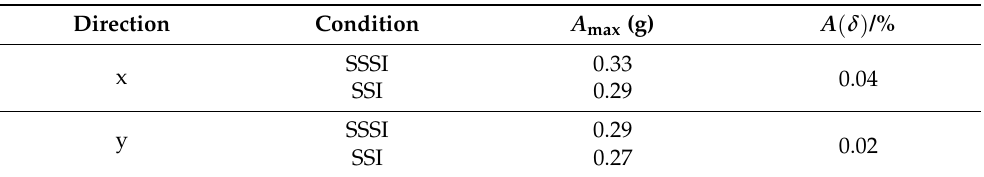
Table 13. Relative changes of x and y peak accelerations of reference points on key floors of SSI system and SSSI system.